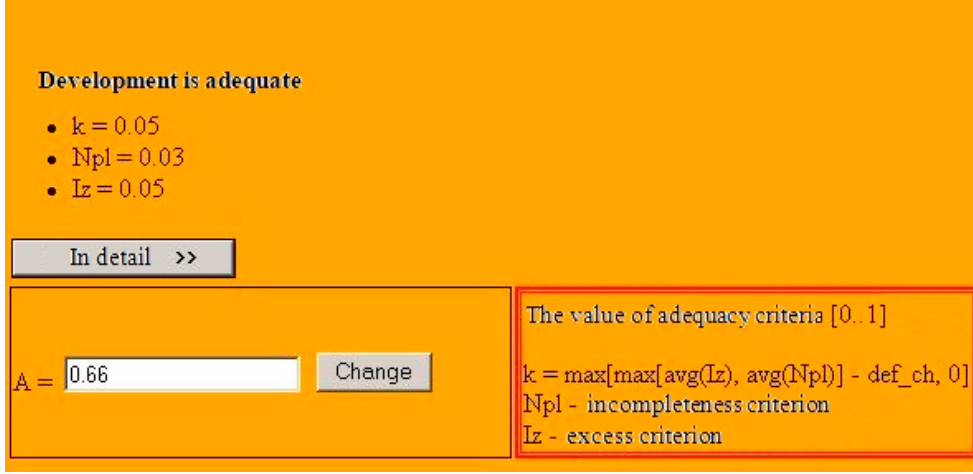
Figure 9. Interface for monitoring the adequacy of ontology development.